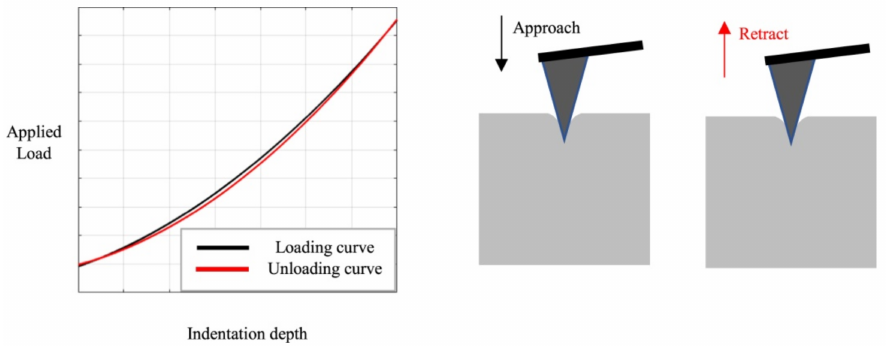
Figure 6. Indentation experiment with loading and unloading curves. Reprinted from [29], originally published under a CC-BY